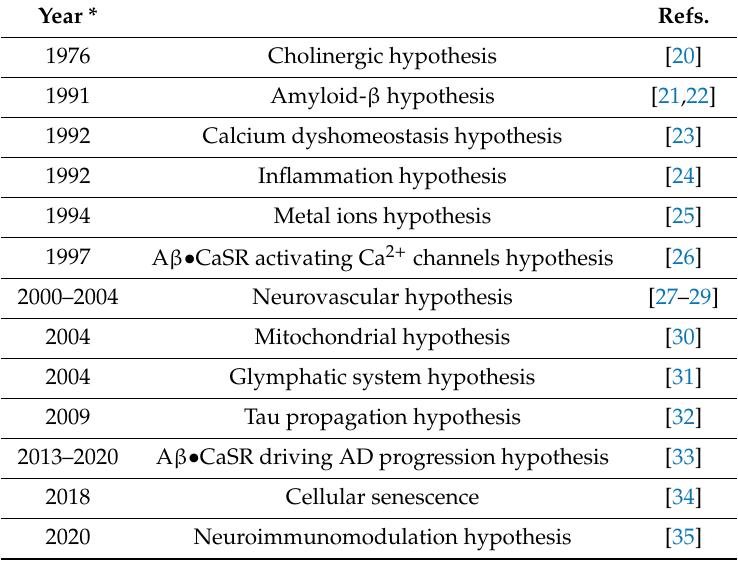
Table 1. Time-line hypotheses regarding the causes of SAD / LOAD.